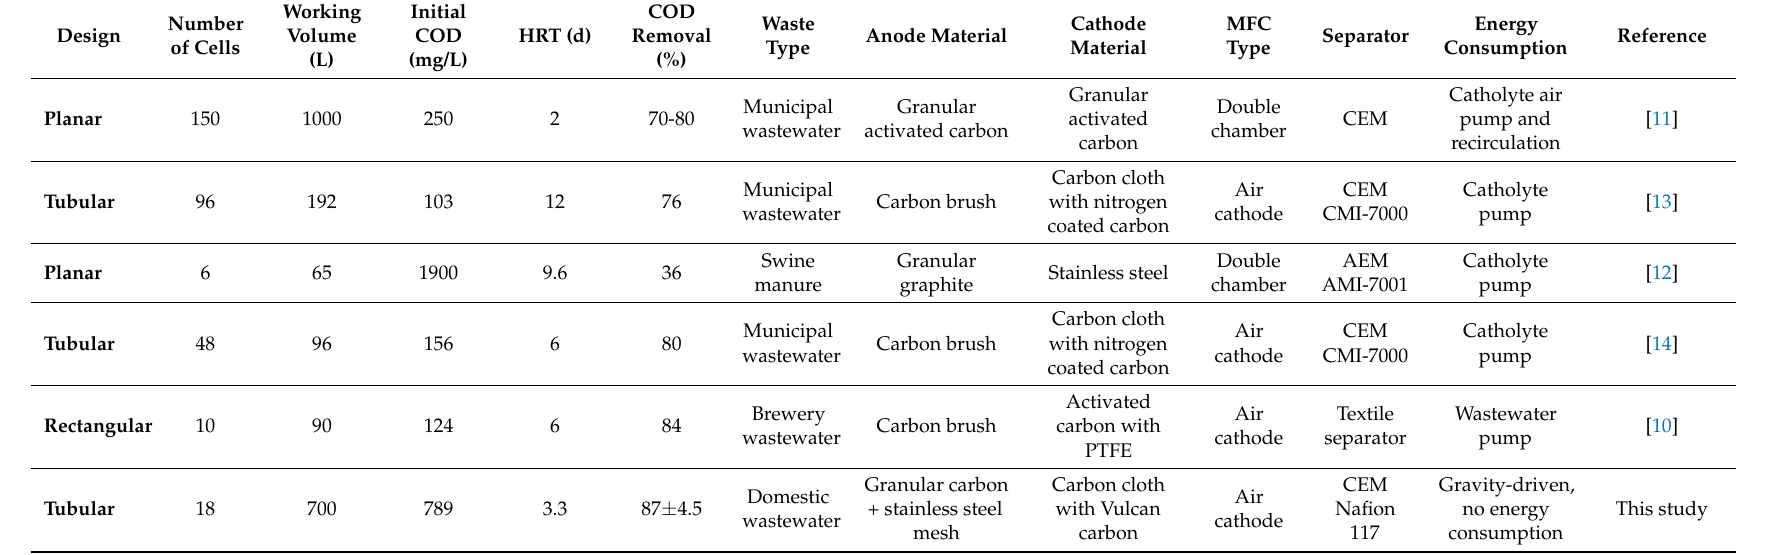
Table 3. Summary of design for scale-up systems using microbial fuel